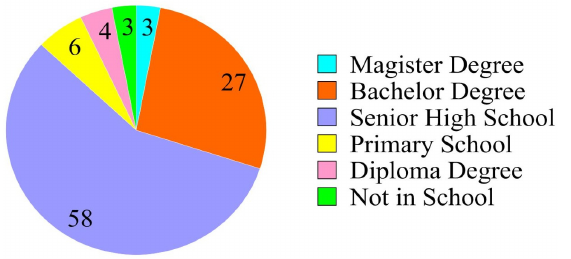
Figure 1. The latest education of respondents.